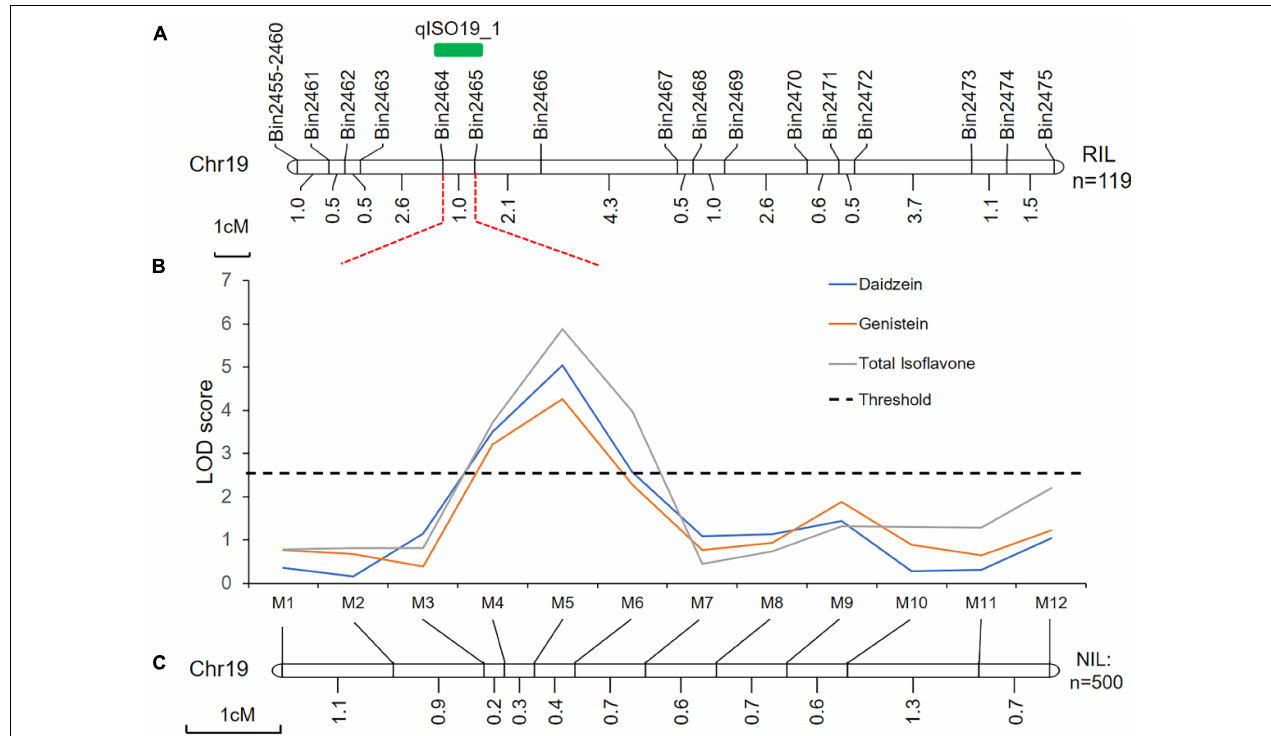
FIGURE 1 | Genetic and physical maps of the qISO19-1 region. (A) Fine-mapping of the QTL qISO19-1 on soybean chromosome 19 using the RIL population. Genetic distances, in cM, are shown below the chromosome, and the locations of the markers and qISO19-1 are shown above. (B) LOD scores for isoflavone contents (daidzein and total isoflavone) over QTL qISO19-1 on chromosome 19. LOD scores were calculated independently by ICIM. The threshold LOD value was 2.5. (C) Genetic map showing the redefined position of qISO19-1 on chromosome 19 based on the BC 2 F 3 population.